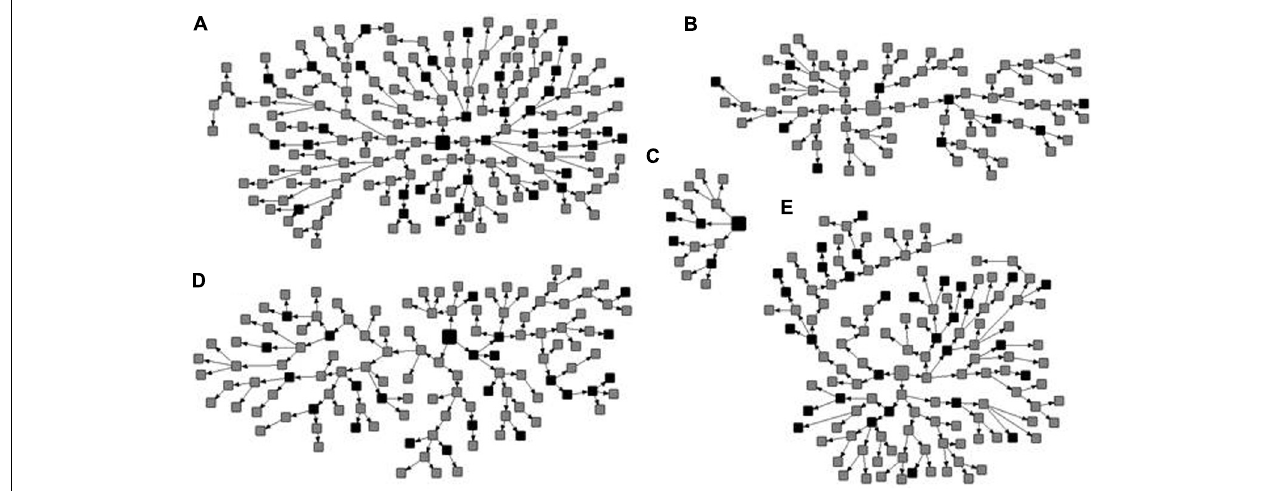
FIGURE 1 | Recruitment networks (A–E) of 522 men who have sex with men (MSM) from Central-Western Brazil. The seeds are indicated by large squares and recruits by small squares. The identified HIV-1 seropositive MSM are shown in black and the other participants in gray.